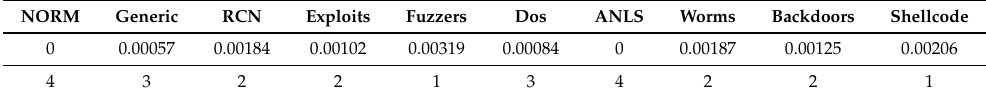
Table 6. Each attack type corresponds to the packet loss rate level.